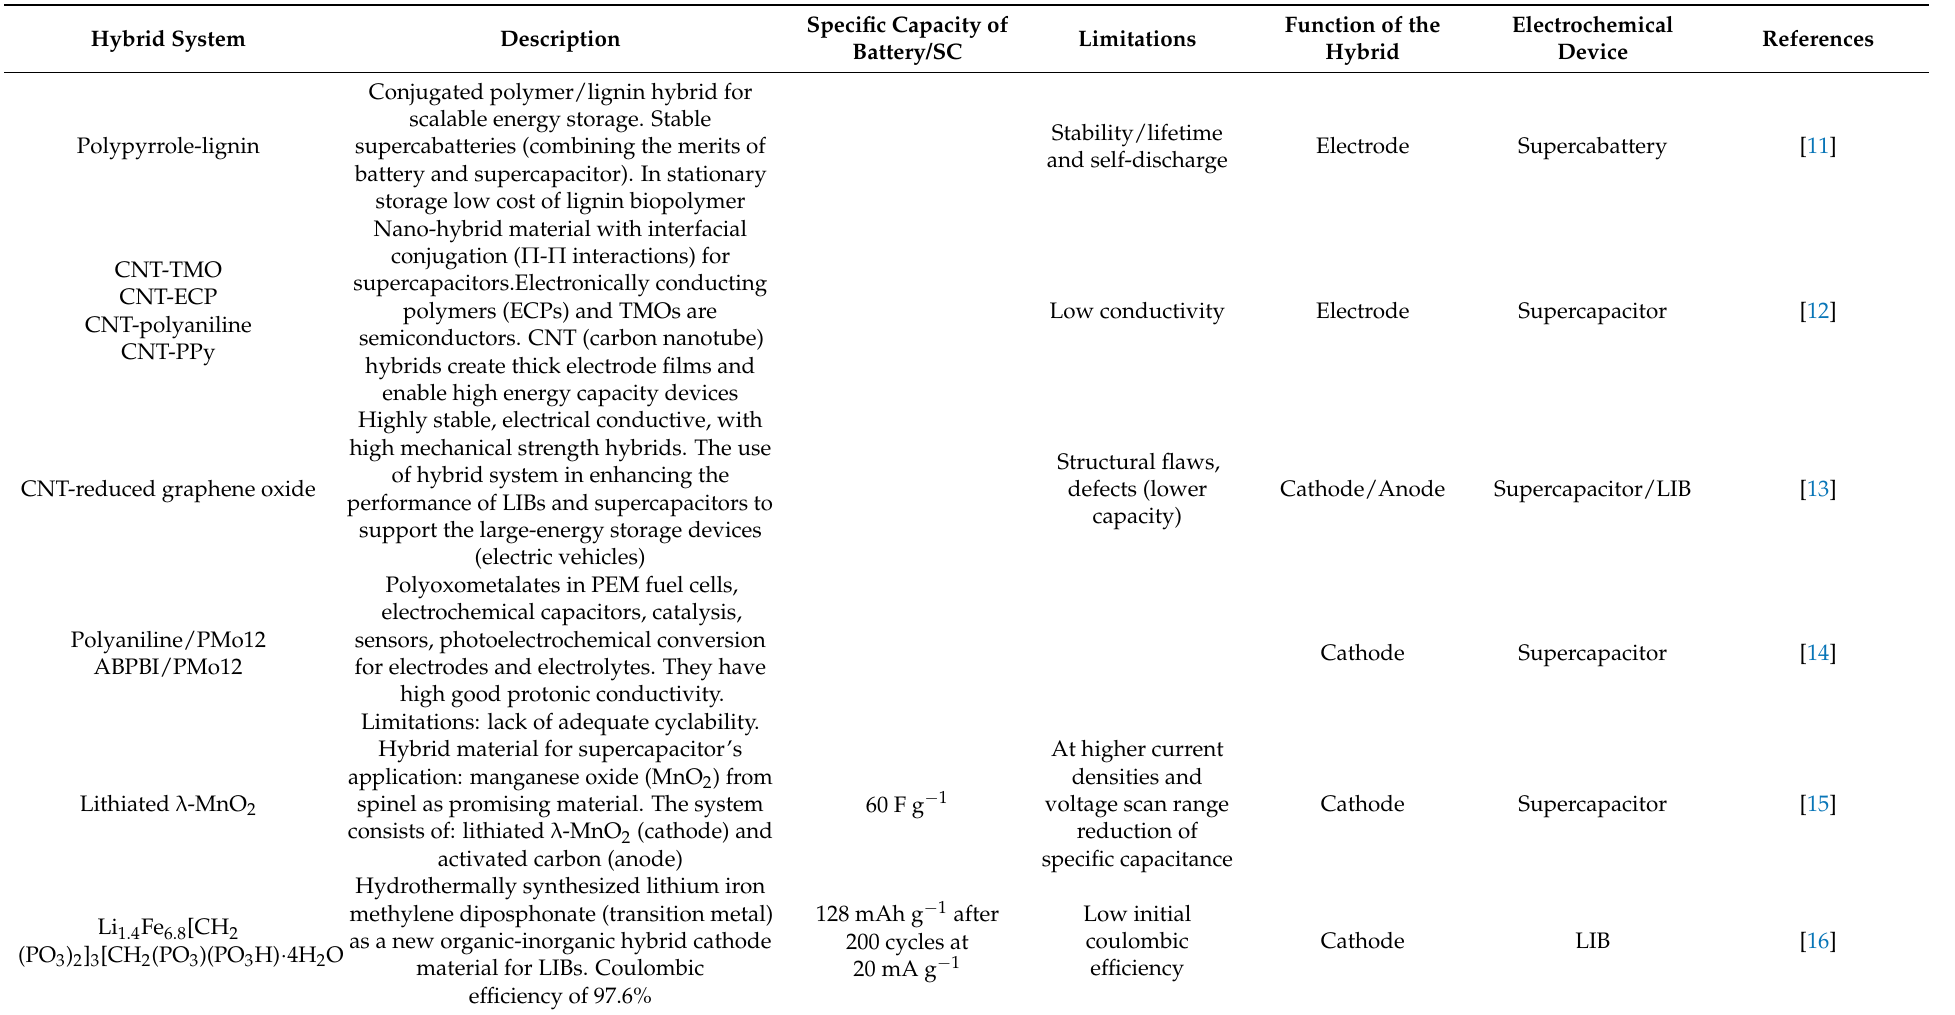
Table 1. Some hybrid materials applied in electrochemical